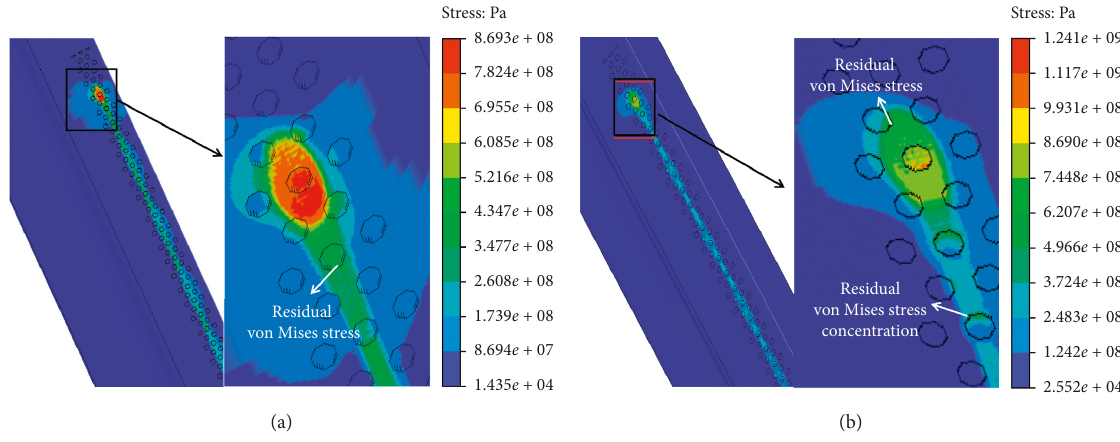
Figure 15: Field of von Mises stress on the rail: (a) nonhardening material; (b) hardening material.